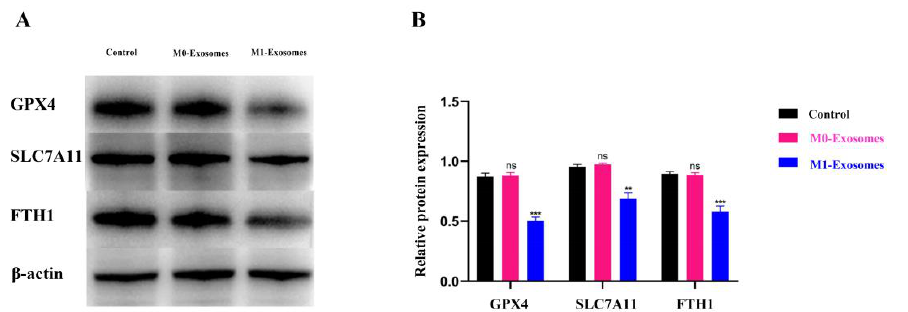
Figure 5. Levels of ferroptosis proteins in neuronal cells following different treatments. ( A ) Expression of GPX4, SLC7A11, and FTH1 in the control, M0-Exosome, and M1-Exosome groups was measured by Western blot. ( B ) Quantitative protein results from Western blots (ns p > 0.05, ** p < 0.01, *** p < 0.001). Data are presented as the mean ± SD of three independent experiments.